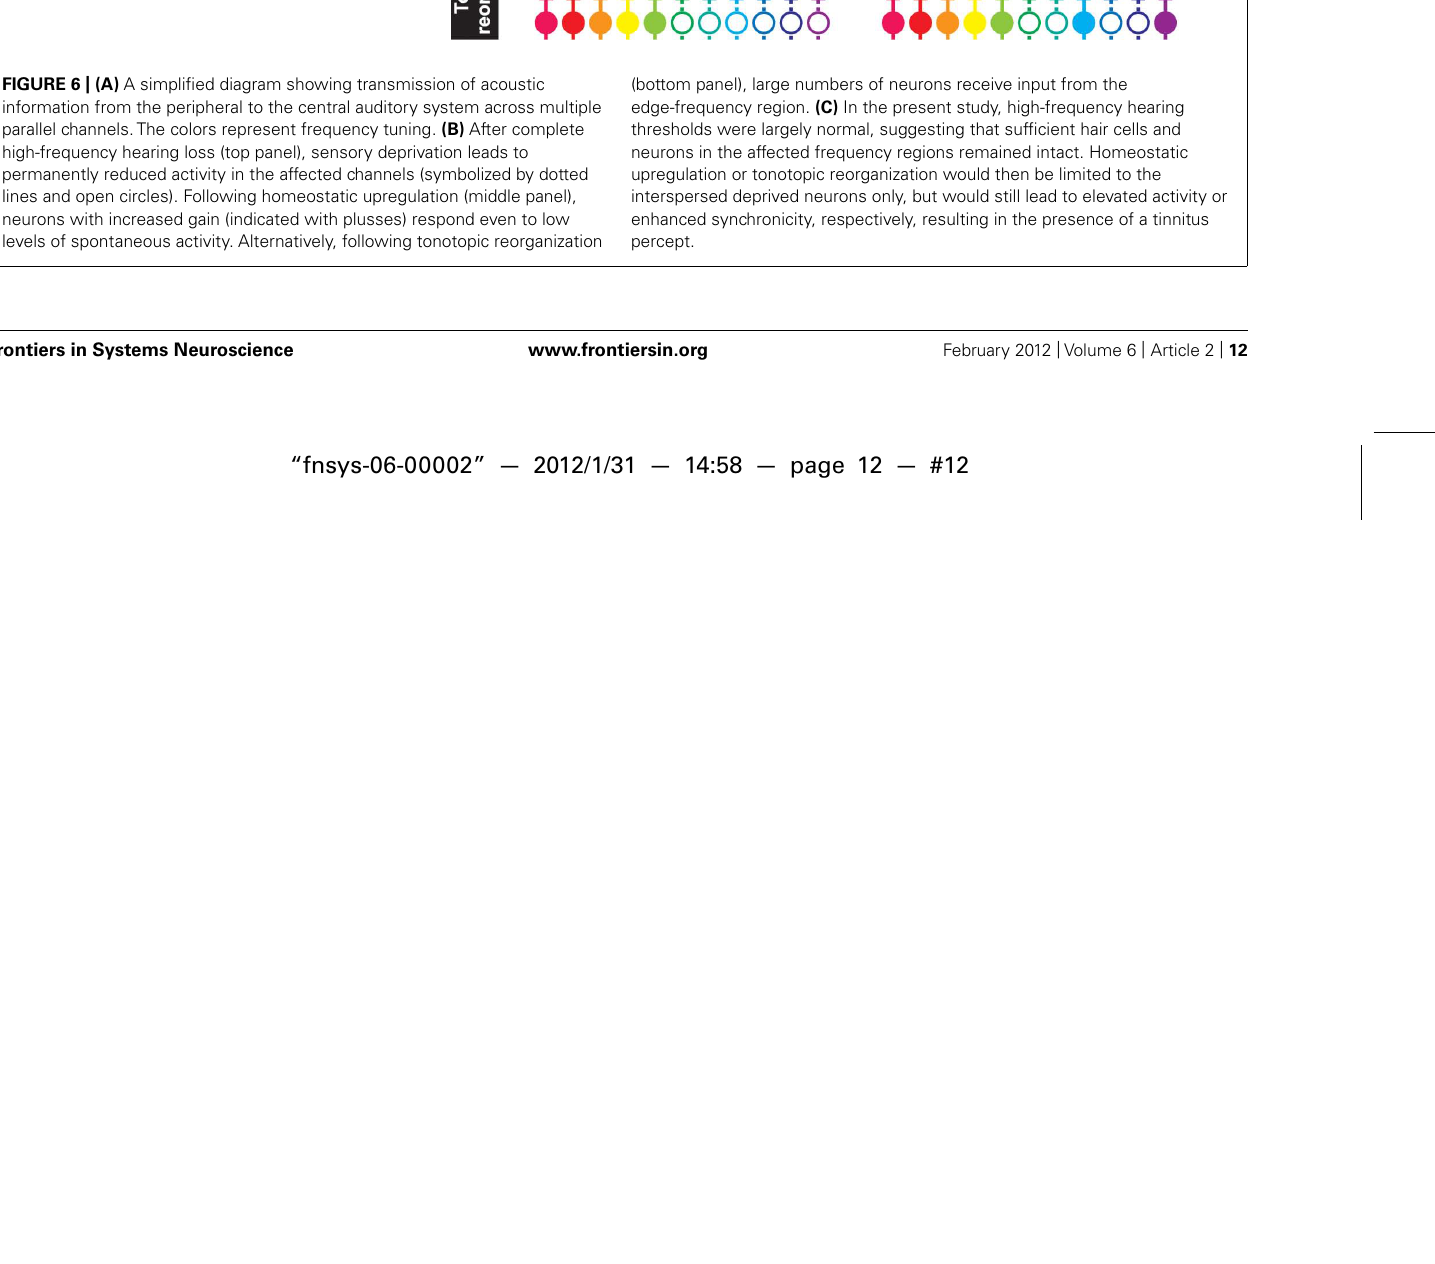
FIGURE 6 | (A) A simplified diagram showing transmission of acoustic information from the peripheral to the central auditory system across multiple parallel channels.The colors represent frequency tuning. (B) After complete high-frequency hearing loss (top panel), sensory deprivation leads to permanently reduced activity in the affected channels (symbolized by dotted lines and open circles). Following homeostatic upregulation (middle panel), neurons with increased gain (indicated with plusses) respond even to low levels of spontaneous activity. Alternatively, following tonotopic reorganization